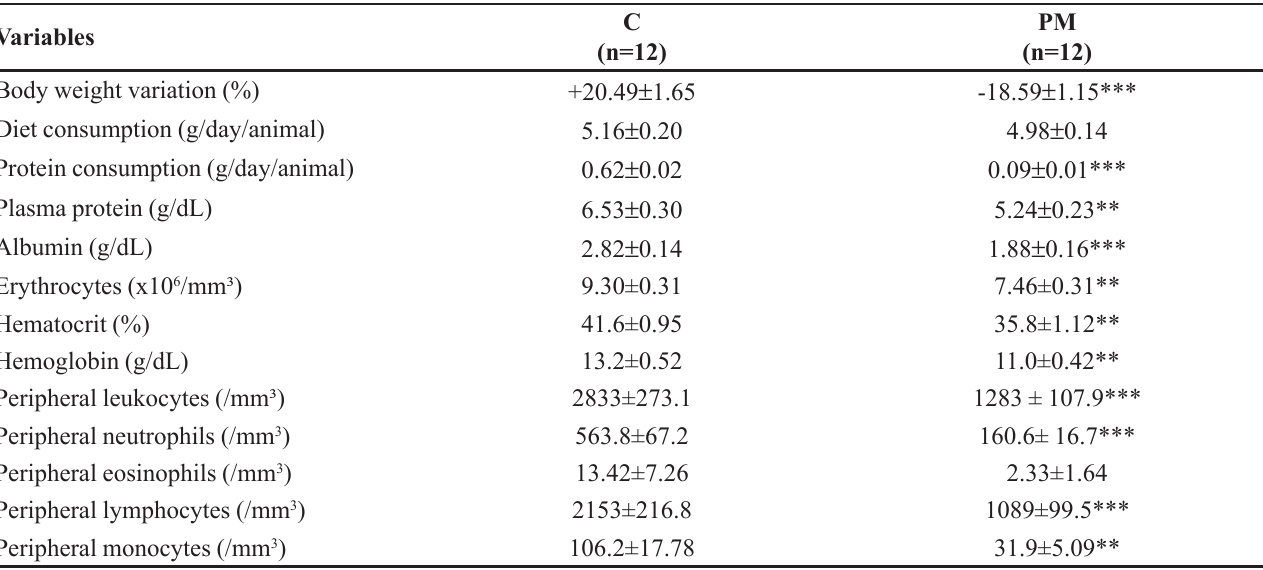
TABLE I - The body weight variation, diet and protein consumption, concentrations of plasmatic protein and albumin, and hemogram in control (C) and protein malnourished (PM) animals Variables